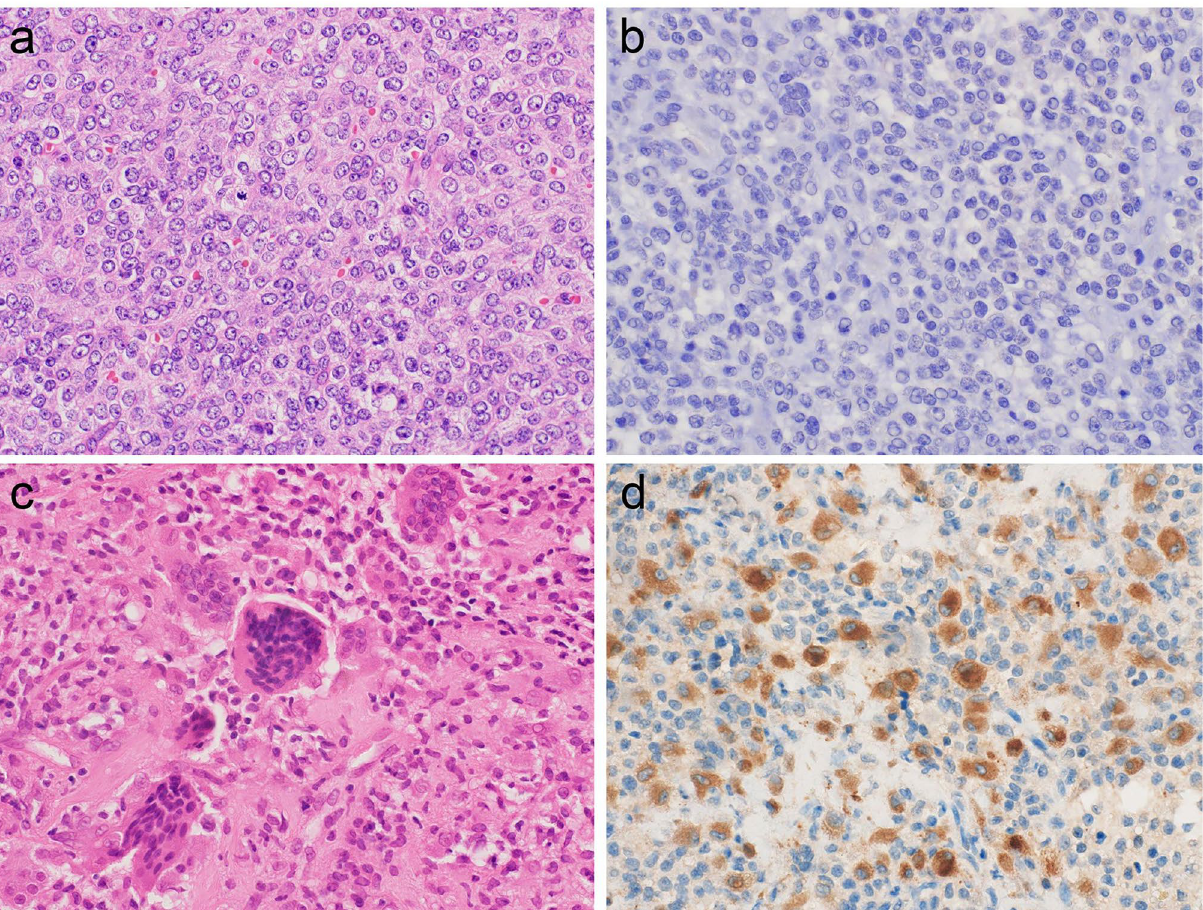
Fig. 2 Pathological findings of MTSGCT and DTSGCT originated in the intervertebral joint of thoracic vertebra a. MTSGCT consisted of diffuse proliferation of round to ovoid mononuclear tumor cells with coarse chromatin and conspicuous nucleoli. Mitotic figures were observed b. The mononuclear tumor cells were negative for